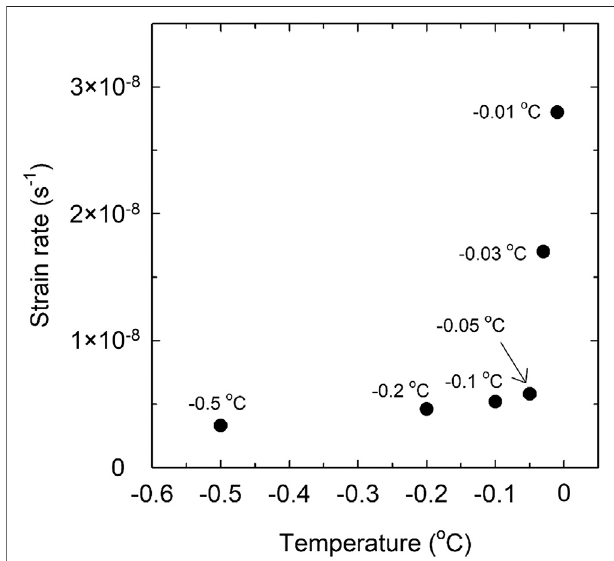
FIGURE1 | High-temperature creep data from uniaxial compression experiments on laboratory-made polycrystalline ice, replotted from Morgan (1991). The octahedral stress was 0.1 MPa. Strain rates are minimum values of secondary creep. A fi t to Morgan ’ s (1991) data gathered at lower temperatures ( − 32.5 to − 5 ° C) yields an activation energy in the Arrhenius relationthatunderestimates themeasured strainrate at − 0.01 ° Cbyafactor of ∼ 10.Exponential thickeningofpre-meltedwater fi lmsatgrainboundarieswith increasing temperature is thought to be responsible for enhanced strain rates (Hooke,